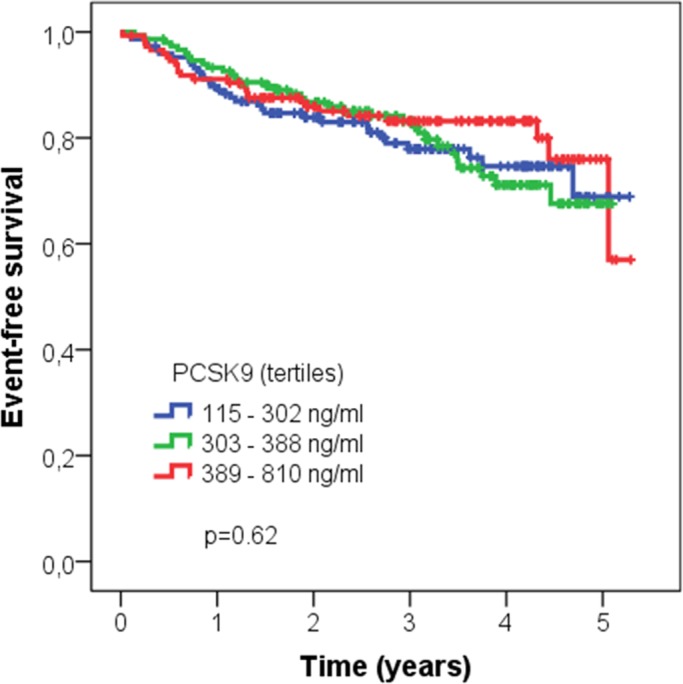
Association of tertiles of PCSK9 with cardiovascular outcome; Kaplan-Meier analysis followed by log-rank test.